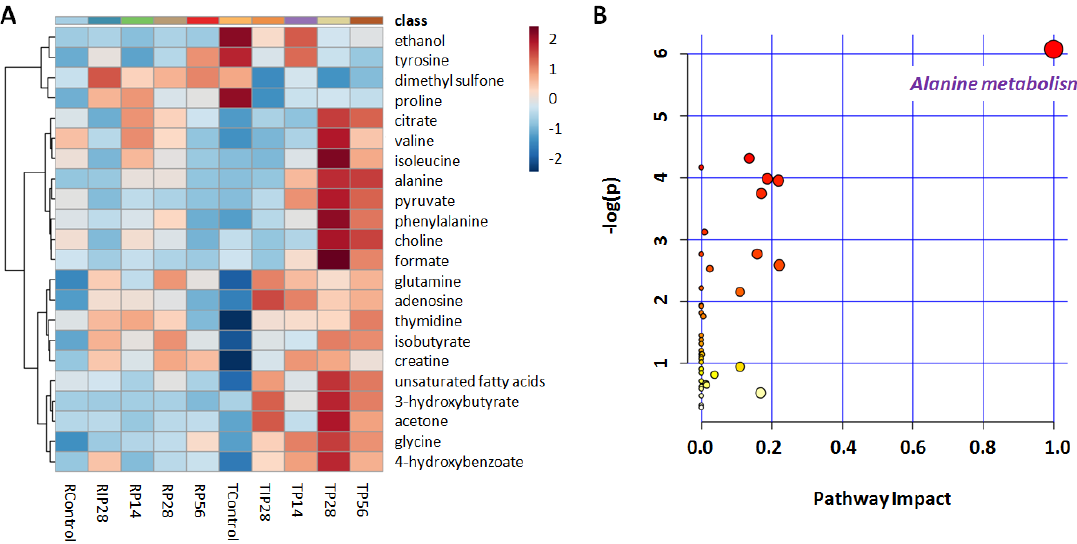
Figure 6. ( A ) Heat maps for average contents of 22 differential metabolites in all the groups with normalized data and auto-scale features. ( B ) Bubble plot of pathway enrichment analysis of 22 differential metabolites induced by high-dose psoralen (56 mg/kg).